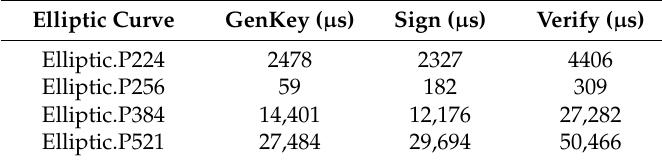
Table 6. ECC execution time on Intel Xeon Silver 4116 CPU @ 2.10 GHz Centos 7.7 kernel 3.10.0.